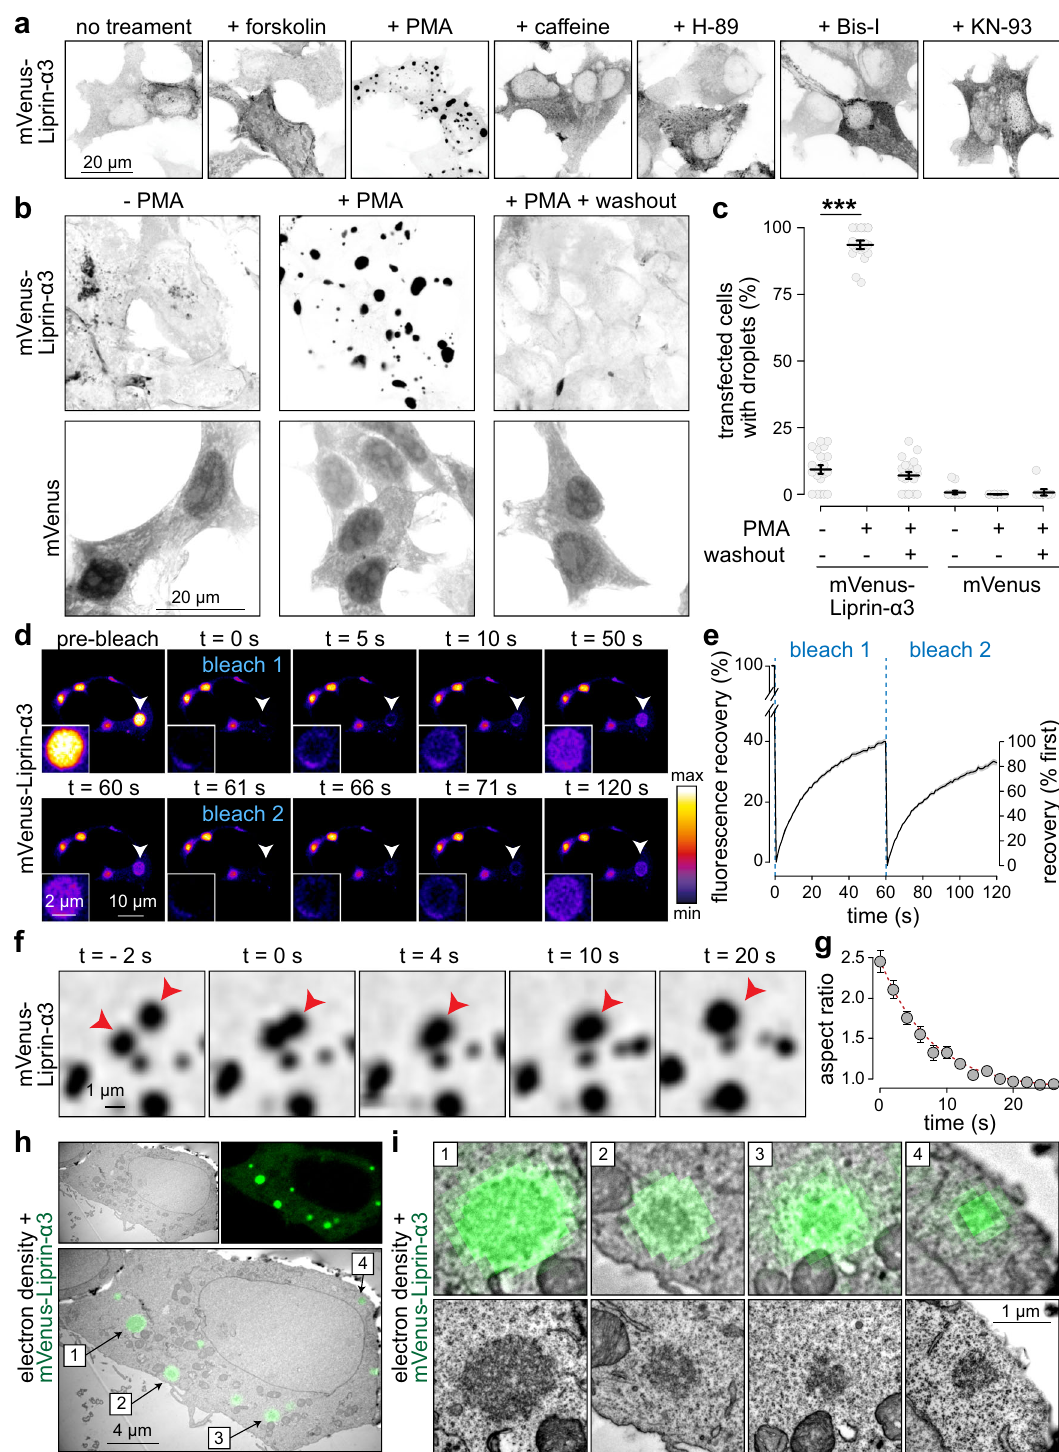
(Fig. 2c). Anti-phospho-S764 antibody signals were unaffected by the same manipulations (Supplementary Fig. 2d). Furthermore, phospho-S760 antibodies detected a signal increase while phospho- is directly phosphorylated by PKC. Phospho-S760 Liprin- α 3